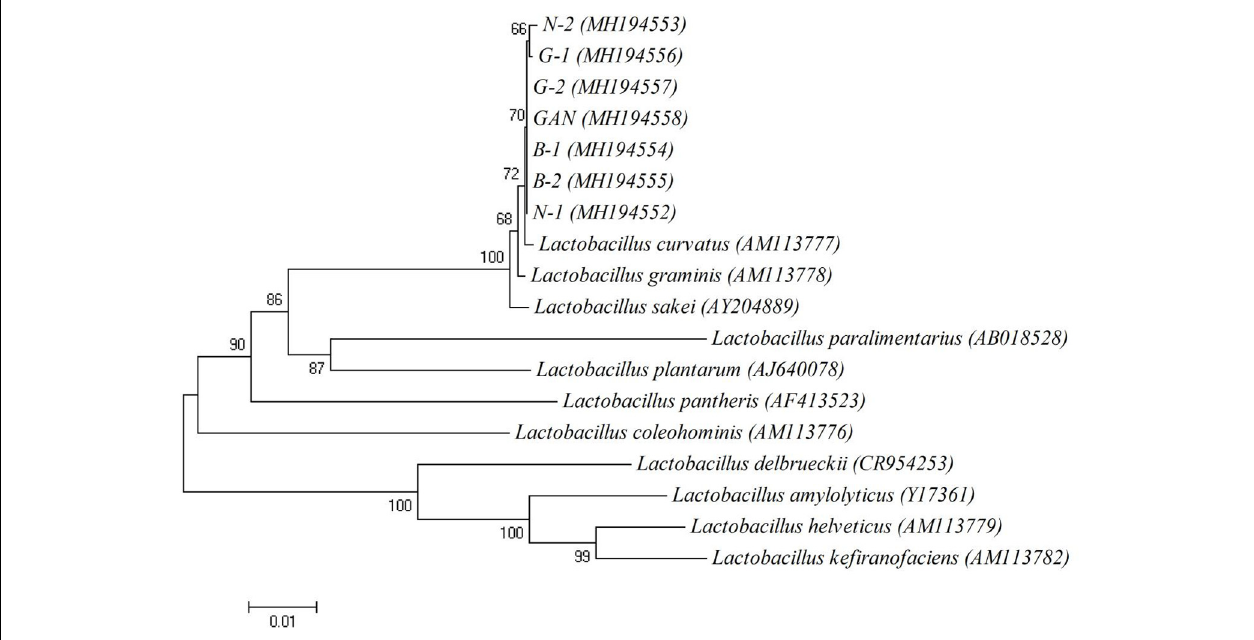
FIGURE 1 | The phylogenetic tree based on 16S rDNA sequences. Numbers in parentheses represent accession numbers of 16S rDNA sequences of representative strains. The scale bar indicates 0.01 nucleotide substitution per position.